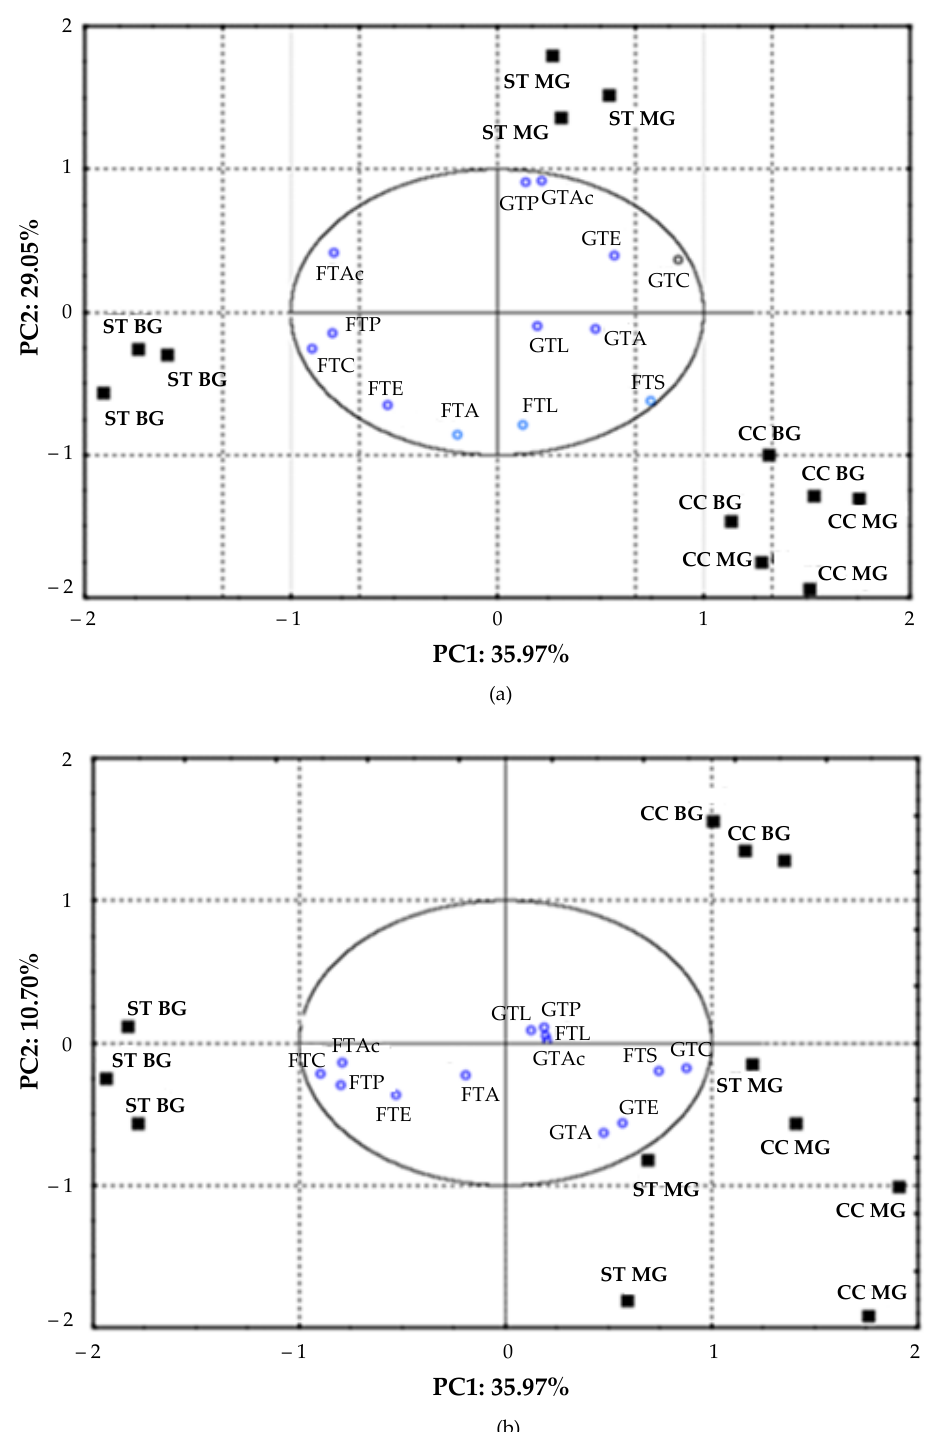
Figure 2. Principal component analyses (PCA) of free and glycosylate aroma compounds are reported showing scores plot and projection of variables on ( a ) PC 1 vs. PC 2 and ( b ) PC 1 vs PC 3 components. Variables correspond to total free and glycosylated alcohols (FTA and GTA), esters (FTE and GTE), carboxylic acids (FTC and GTC), phenols (FTP and GTP), acetamides (FTAc and GTAc), sulfurs (FTS), and lactones (FTL and GTL). Cases grouping was calculated considering each soil tillage (ST), cover crop (CC), monolateral Guyot (MG), and bilateral Guyot (BG) interactions.